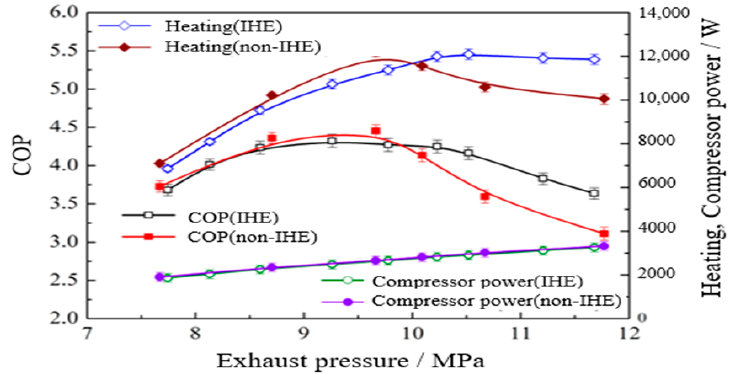
Figure 3. Outlet gas cooler temperature (T o-gc ) and outlet hot water temperature (T o-hw ) change with exhaust pressure.